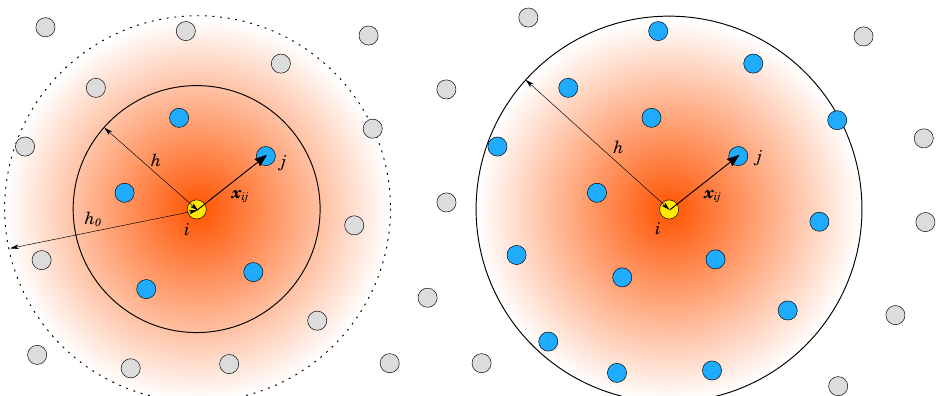
Figure 1. Neighbor interaction in LDD ( left image ) versus SPH and MPS ( right image ). The set of neighboring nodes N found in the compact sphere (blue) with radius h and centered at location x i . The gradient depicts weighting of the interaction based on the distance from x i